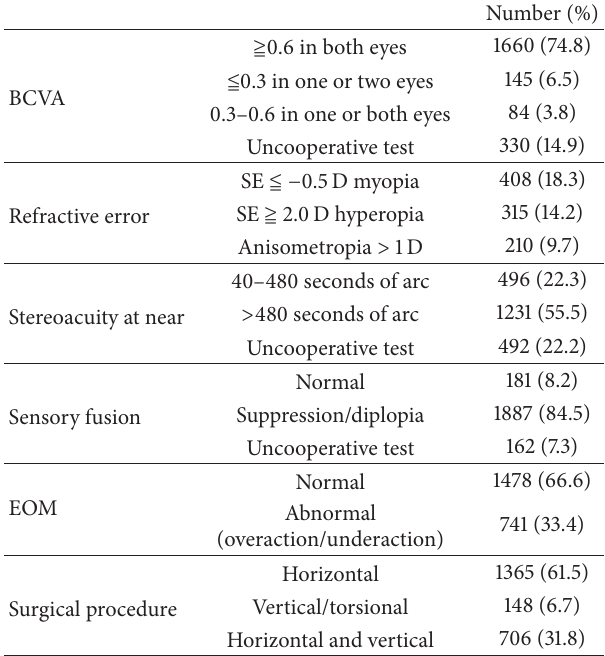
Table 2: Basic characteristics of the 2219